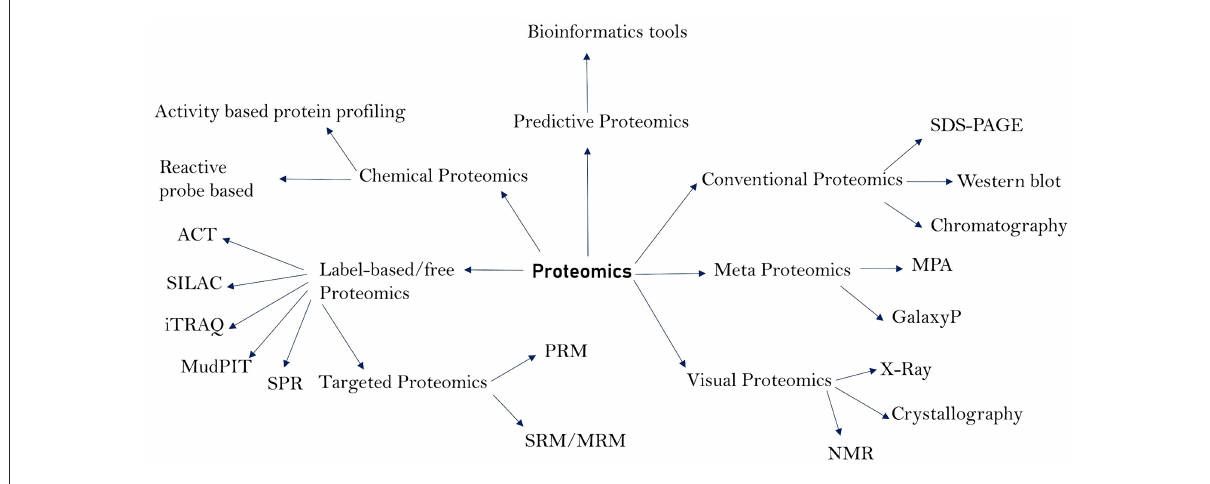
FIGURE1 Major proteomics techniques and their